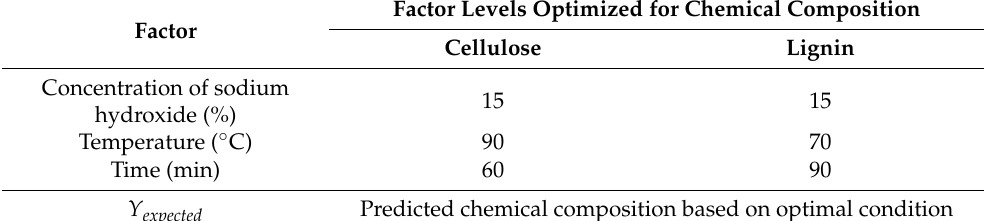
Table 4. Optimized factor levels for the chemical composition of cellulose and lignin. Total Factor Levels Optimized for Chemical Composition Factor DOF = degree of freedom; SS = sum of square; MS = mean sum of squares; F = F-test statistic; S ’ = Cellulose Lignin pure sum of squares. Concentration of sodium 15 hydroxide (%) Temperature ( ◦ C) Predicted chemical composition based on optimal condition